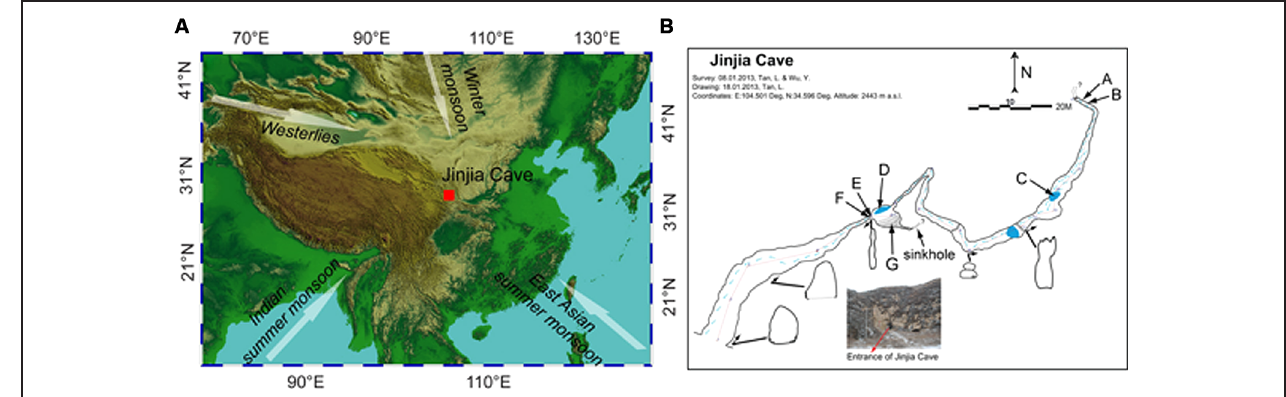
FIGURE 1 | Location (A) and plan view (B) of Jinjia Cave. Arrows in (A) indicate the directions of the east Asian summer monsoon, Indian summer monsoon, east Asian winter monsoon, and westerlies. The letters A and B (cave